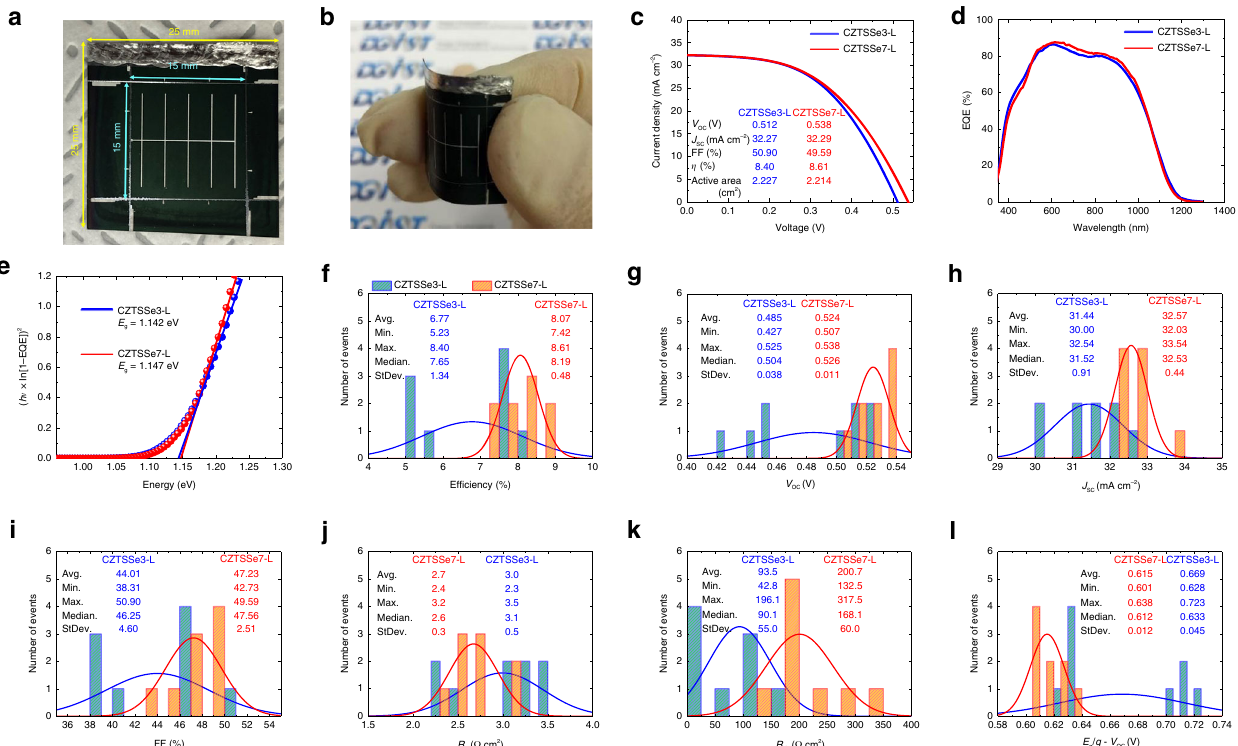
Fig. 3 Photovoltaic device properties of fl exible CZTSSe3-L and CZTSSe7-L. a 1 cell with a size of ~15 mm × 15 mm is included in the Mo foil substrate with a size of ~25 mm × 25 mm and b fl exed sample image. All samples are with cell areas larger than 2 cm 2 for 9 devices of each type. c Current density-voltage curves, d EQE curves at a bias of 0 V, and e calculated bandgaps of CZTSSe3-L and CZTSSe7-L samples with the highest ef fi ciencies (from KIER certi fi cate, Supplementary Figs. 7g, h, and 8m, n). f The average ef fi ciency values are 6.77% with a StDev of 1.34 for CZTSSe3-L and 8.07% with a StDev of 0.48 for CZTSSe7-L. g The average V OC values are 0.485V with a StDev of 0.038 for CZTSSe3-L and 0.524 V with a StDev of 0.011 for CZTSSe7-L. h The average − 2 with a StDev of 0.91 for CZTSSe3-L and 32.57 mA cm − 2 with a StDev of 0.44 for CZTSSe7-L. i The average FF values are J SC values are 31.44 mA cm 44.01% with a StDev of 4.60 for CZTSSe3-L and 47.23% with a StDev of 2.51 for CZTSSe7-L. j The average R s values are 3.0 Ω cm 2 with a StDev of 0.5 for CZTSSe3-L and 2.7 Ω cm 2 with a StDev of 0.3 for CZTSSe7-L. k The average R sh values are 93.5 Ω cm 2 with a StDev of 55.0 for CZTSSe3-L and 200.7 Ω cm 2 with a StDev of 60.0 for CZTSSe7-L. l The average V OC de fi cit ( E g /q − V OC ) values are 0.669 V with a StDev of 0.045 for CZTSSe3-L and 0.615 V with a StDev of 0.012 for CZTSSe7-L